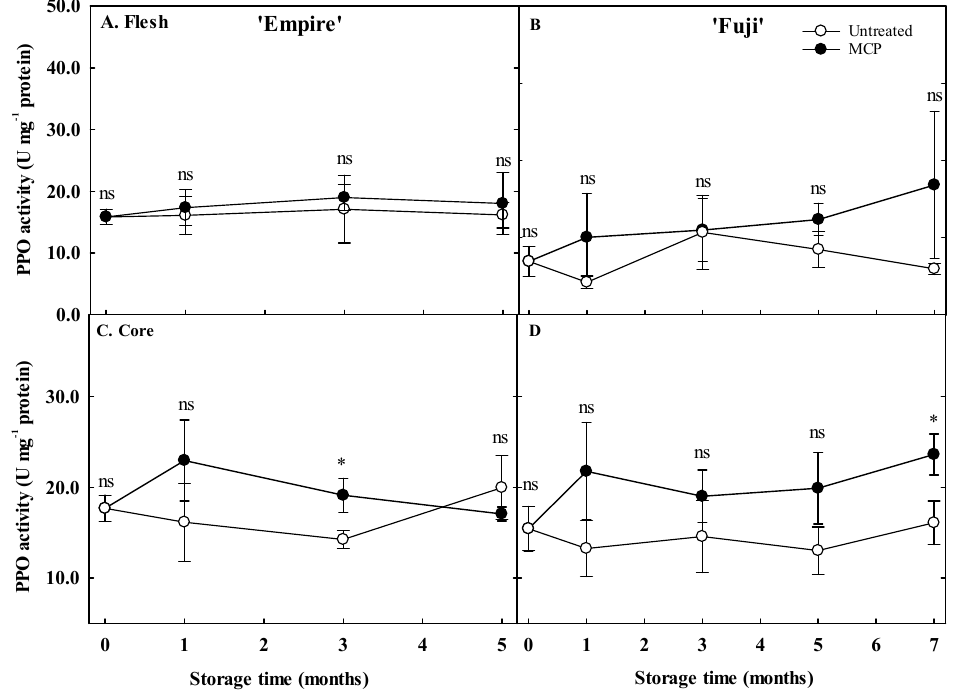
Figure 3. PPO (Polyphenol oxidase) in flesh ( A , B ) and core tissue ( C , D ) on ‘Empire’ and ‘Fuji’ apples, either untreated or treated with 1 µL·L − 1 1-MCP, and stored at 0.5 °C in air storage for up to five and seven months, respectively. Bars represent error of the means (S.E.M; n = 5) when larger than the dimension of the symbol. ns and * indicate non-significant and significant differences between untreated and 1-MCP treatments at p < 0.05, respectively. PAL is a key enzyme of phenolic metabolism producing chlorogenic acid and caffeic acid derivatives; however, the relationship between enzyme activity and browning is mostly highlighted not in apples [14] but in cut lettuce and other fresh-cut fruit and vegetables. 1-MCP treatment increased PAL activity in the flesh tissue of ‘Empire’ apples during three months of air storage but decreased after five months of storage, compared to values observed for untreated fruit (Figure 4), presumably due to responses to the production of IEC (Figure 1A).